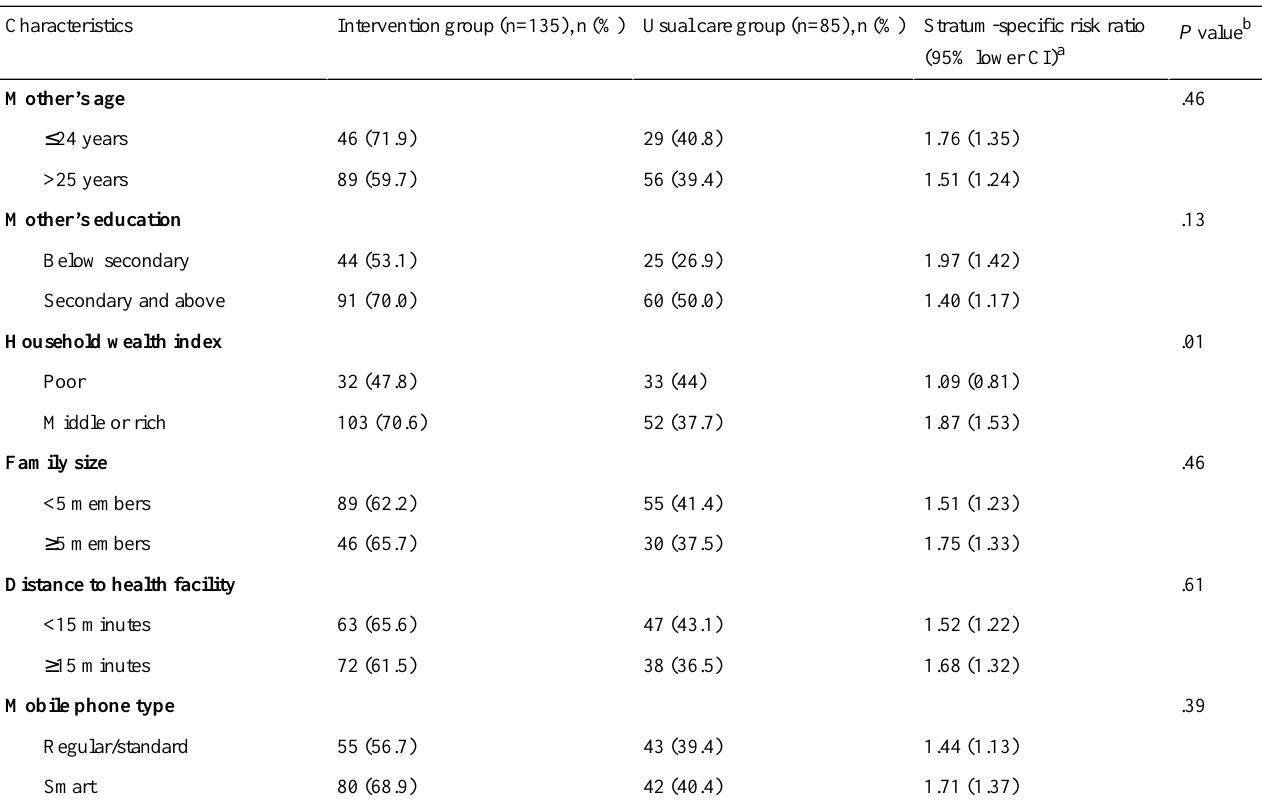
Table 6. Subgroup analysis of the effect of mobile phone text message reminders on timely completion of vaccination in Gondar city, northwest Ethiopia in